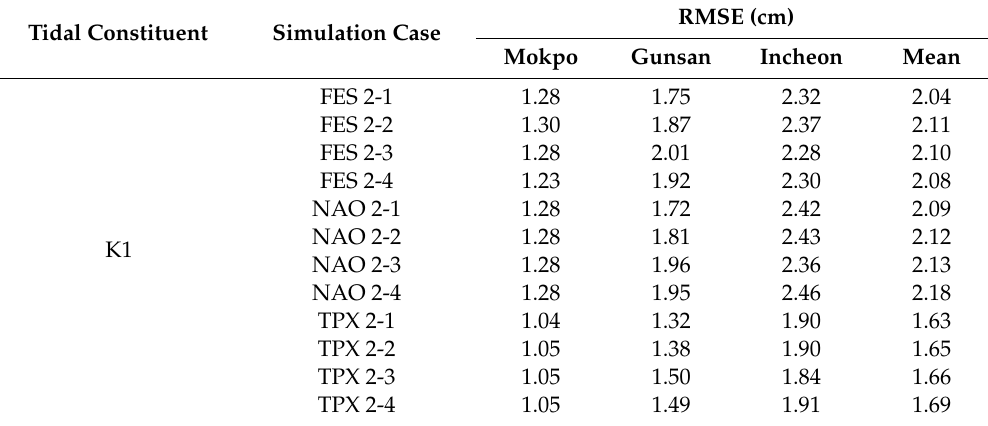
Table A7. RMSE results obtained from non-uniform roughness bottom for K1.